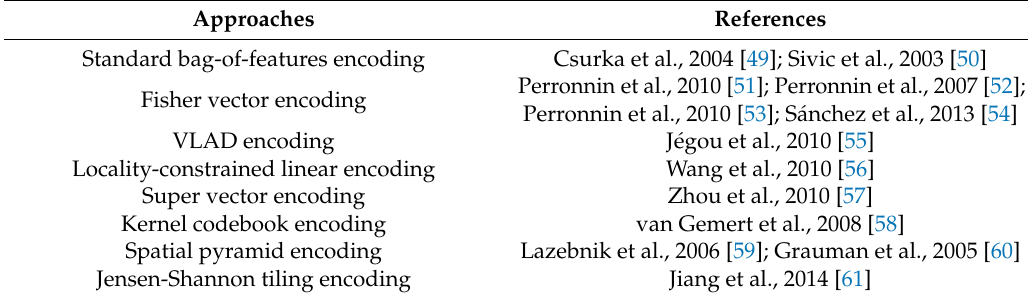
Table 1. Popular approaches and corresponding references for 2D encodings.